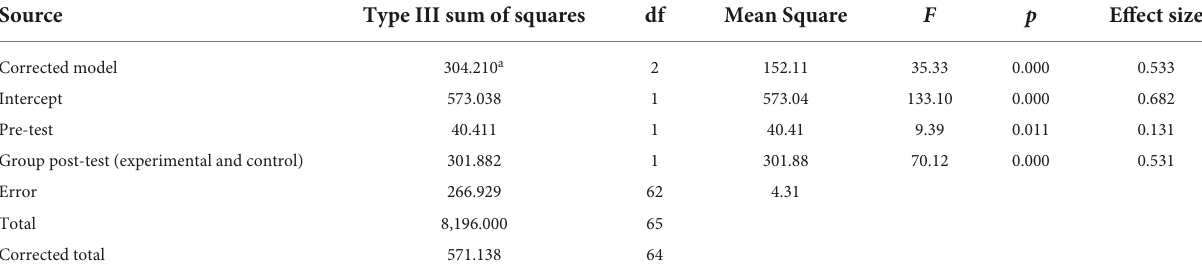
TABLE 3 Analysis of covariance (ANCOVA) result on students’ ability to construct cohesive sentence for composition writing after exposure to concept mapping instruction. Source Type III sum of squares